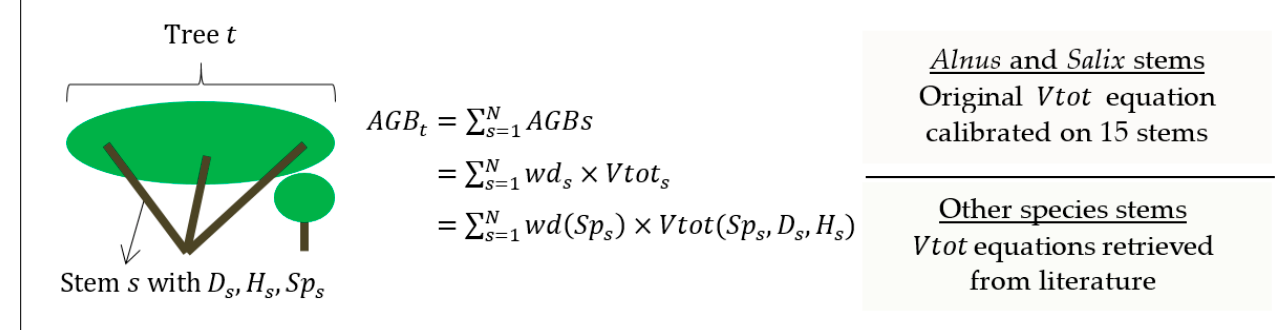
Figure 2. Diagram of the field estimation of tree biomass. t = tree index, s = stem index within the tree t , N = number of stems within the tree t , AGB = aboveground biomass, wd = wood density retrieved from [48], Vtot = total wood volume, Sp = species, D = diameter, H = tree height. A new total volume equation was developed in this study for Alnus and Salix . For other species, volume equations were retrieved from [49,50].